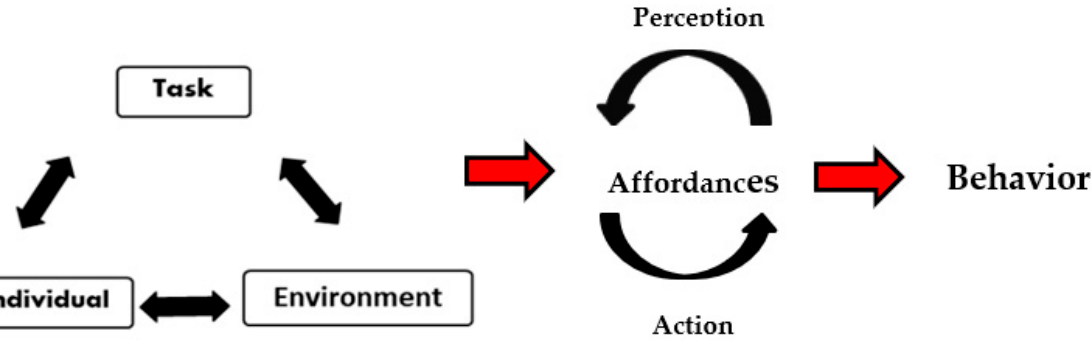
Figure 2. Coordination of behavior emerges from the interaction of key constraints on the performer in the form of functional information-movement couplings through system self-organization [5,55]